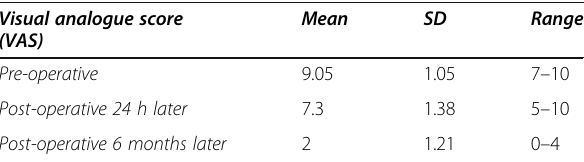
Table 5 Pre- and post-operative visual CK total and CK MB values of the included patients in our